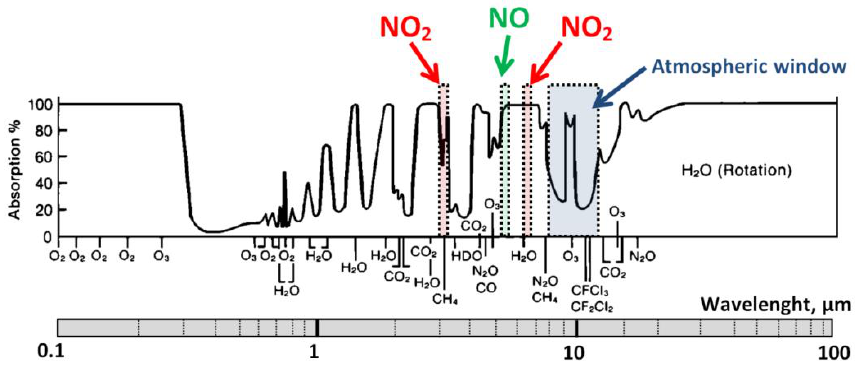
Figure 2. Percentage of atmospheric absorption for radiation passing from the top of the atmosphere to the surface for different GHGs versus NOx and the atmospheric window (based on John F. B. Mitchell [32]).